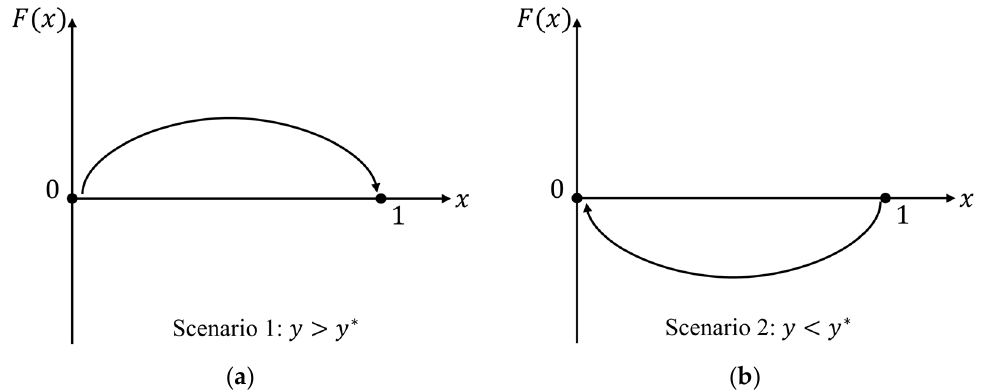
Figure 3. (a) The dynamic trend of the SME’s strategy in the case of 𝑦 > 𝑦 ∗ ; (b) The dynamic trend of the SME’s strategy in the case of 𝑦 < 𝑦 ∗